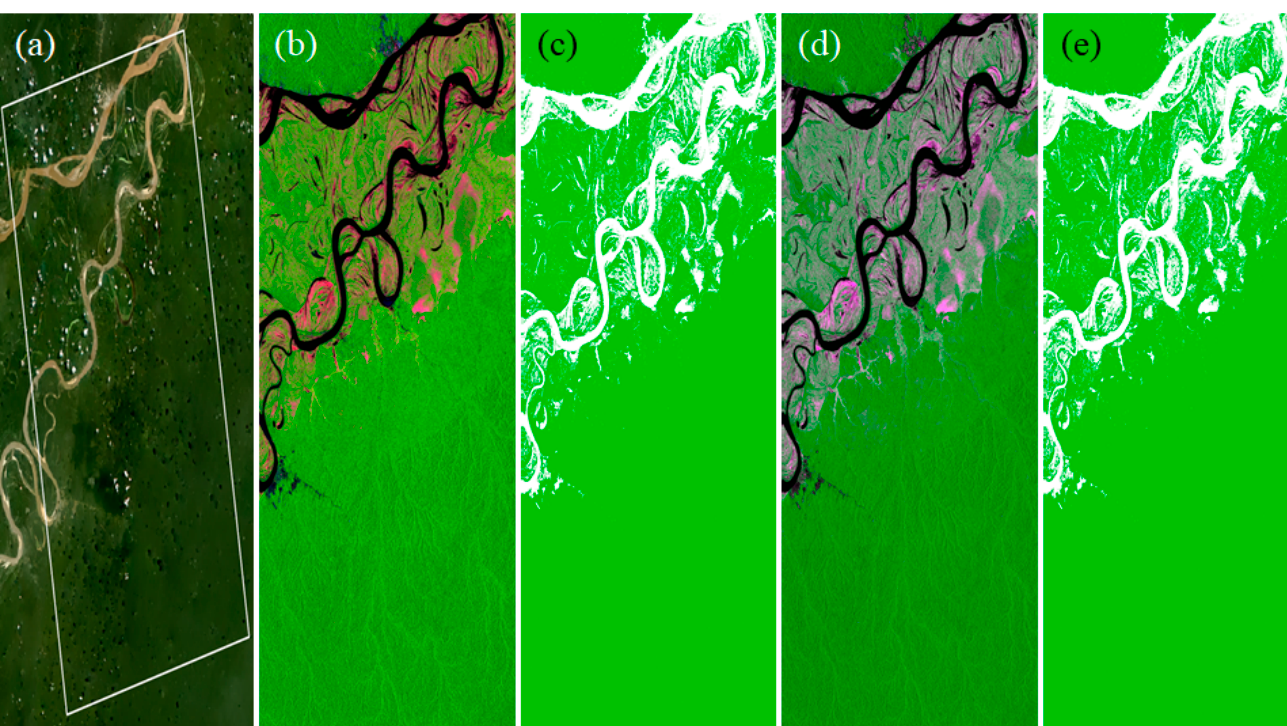
Figure 3. Forest maps of Ucayali River in the Amazon using the proposed method and 6SD method with POLSAR data acquired on 16 April 2016 and a window size of 10 × 20 pixels. ( a ) Mosaic image acquired by Planet/Dove from June to November 2016. The white rectangle shows the observation area of PALSAR-2. ( b ) 6SD RGB image: double-bounce scattering is in red, volume scattering is in green, and surface scattering is in blue. ( c ) Forest map using the 6SD method. ( d ) RGB image of the proposed method: ground scattering is in red and blue, and volume scattering is in green. ( e ) Forest map using the proposed method.